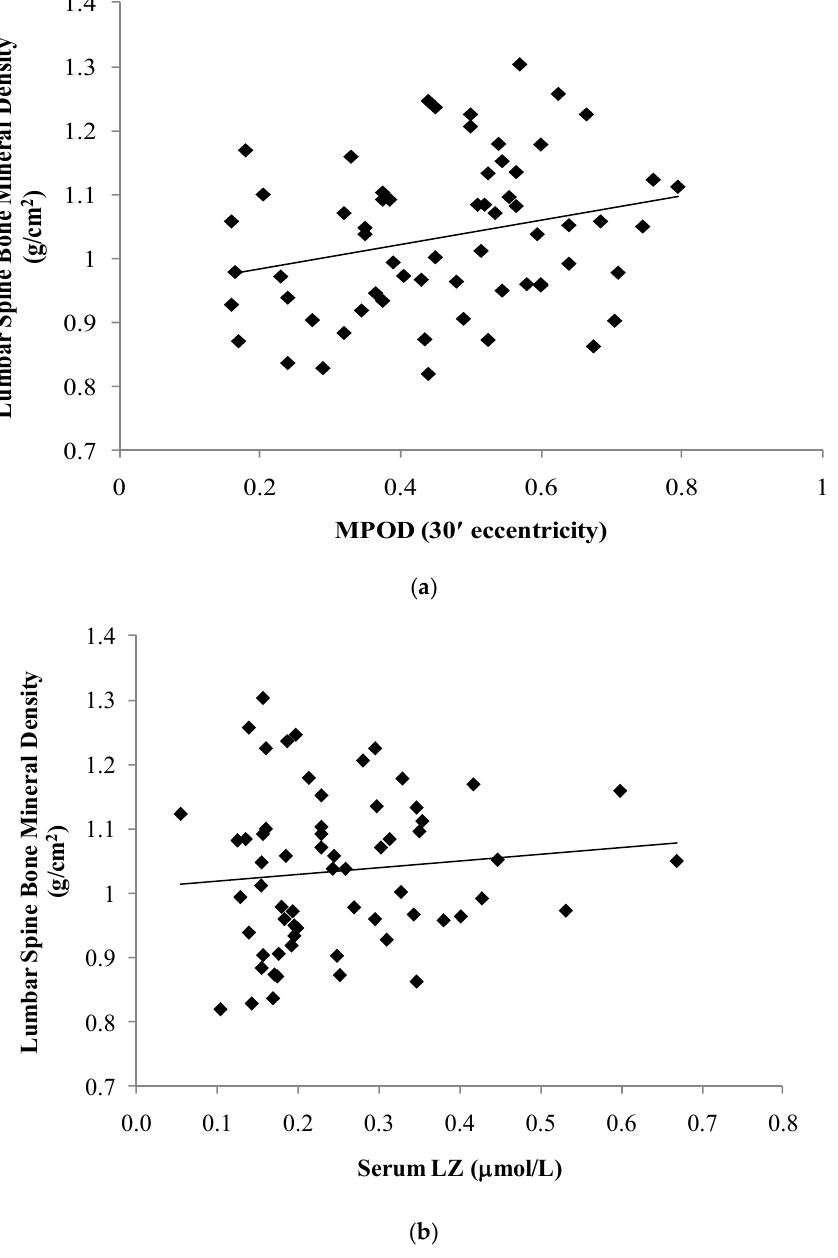
Figure 1. The relationship between the skeletal mass of the lumbar spine and macular pigment optical density (MPOD) at 30 ′ retinal eccentricity ( a ) and serum lutein/zeaxanthin ( b ).